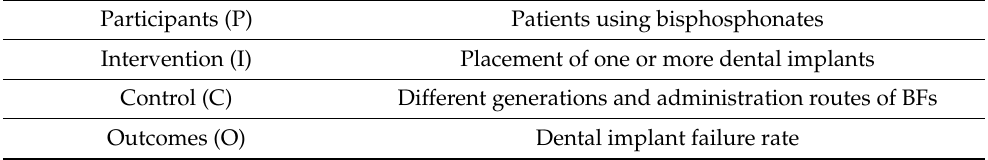
Table 1. PICO characterization. Participants (P) Patients using bisphosphonates Intervention (I) Placement of one or more dental implants Control (C) Different generations and administration routes of BFs Outcomes (O) Dental implant failure